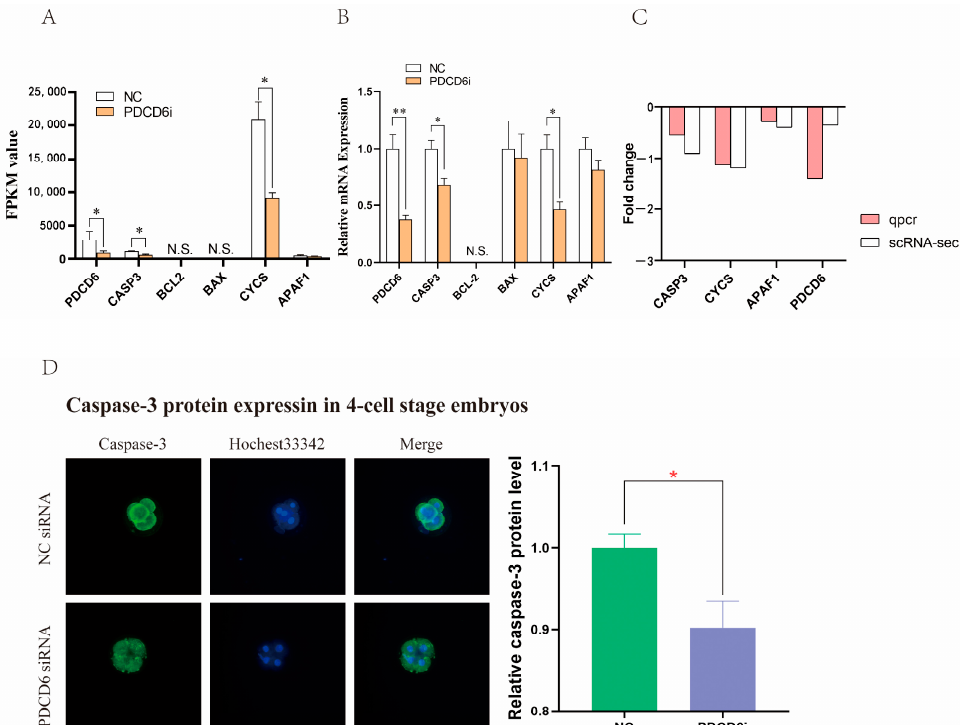
Figure 6. PDCD6 siRNA microinjection inhibited the expression of pro-apoptotic genes in cloned porcine embryos. ( A ) The fragments per kilo base of transcript per million mapped fragments (FPKM) values of the apoptosis-related genes from the RNA sequencing results of the cloned porcine embryos. ( B ) Relative mRNA expression levels of the apoptosis-related genes in the cloned two-cell stage porcine embryos, as measured by qPCR. “*” and “**” represent a significant difference at p < 0.05 and p < 0.01, respectively; “NT” indicates non-detectable values. ( C ) RNA-sequencing and qPCR-measured fold change (PDCD6i vs. NC) in the mRNA level of apoptosis-related genes. ( D ) Comparison of CASP3 protein levels in cloned pig embryos in the NC and PDCD6i groups. This picture was taken by the Nikon fluorescent microscope with a magnification of 200 × .